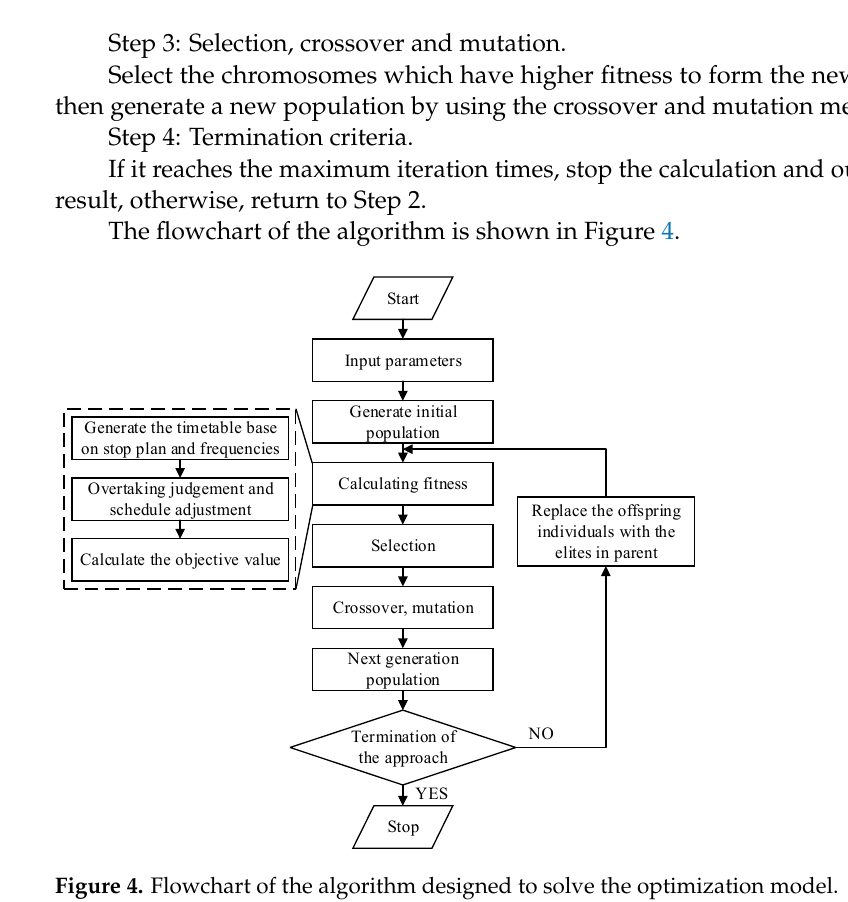
Figure 6. Stations on the Jiangjin Line. Table 2. Inter-station distances on the Jiangjin Line Station No.